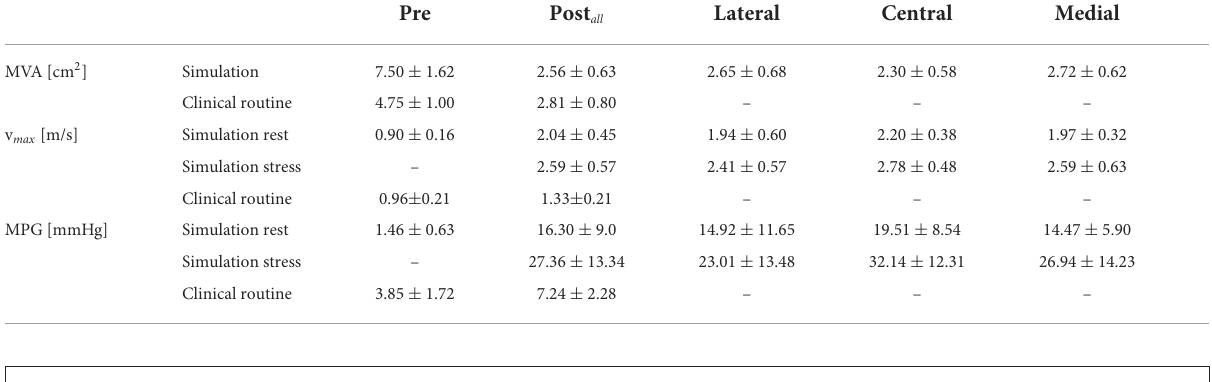
TABLE 2 Hemodynamic results after virtual trans-catheter edge-to-edge repair (TEER) at rest and stress conditions for different device positions.